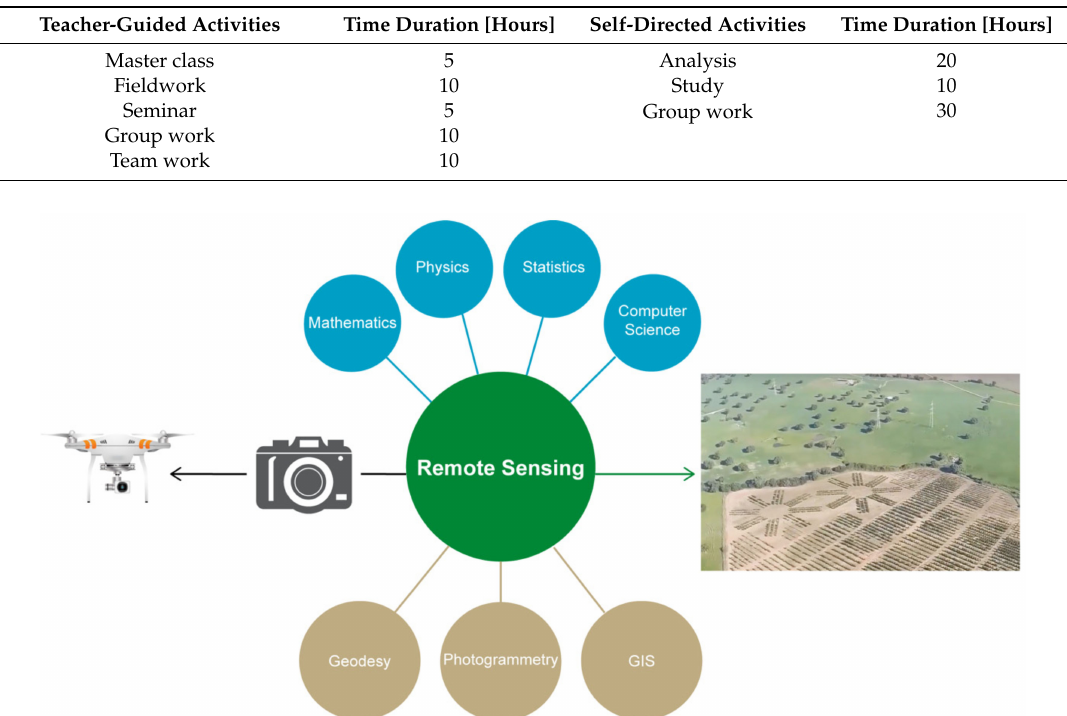
Table1. Typeanddurationofteacher-guidedandself-directedactivitiesfor"UAVsintheAgroforestSector".